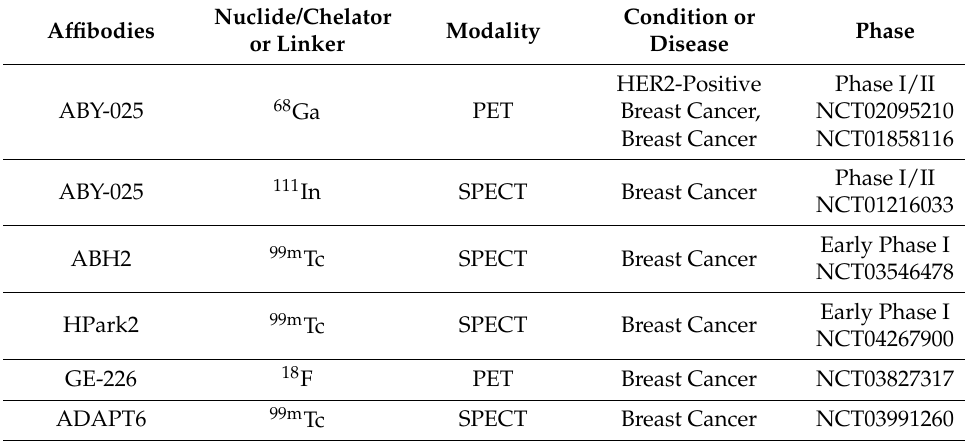
Table 4. The clinical trials of HER2-targeted